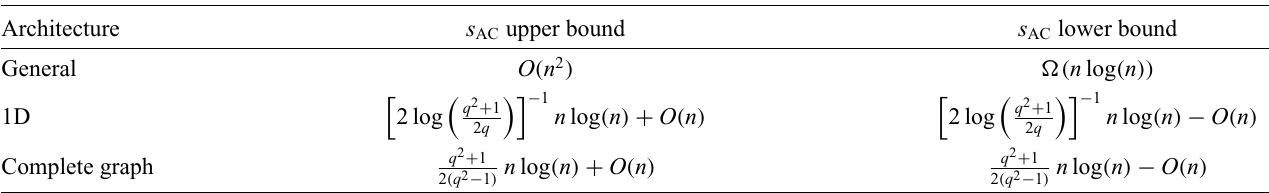
TABLE I. Summary of results: upper and lower bounds on the circuit size s AC at which anticoncentration is achieved for different random circuit